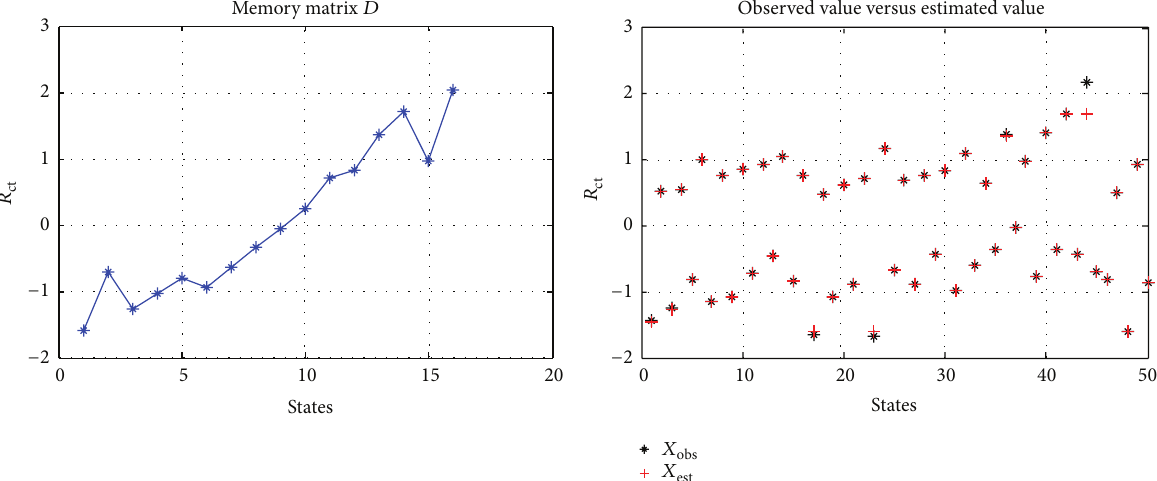
Figure 8: Memory matrix 𝐷 without strong